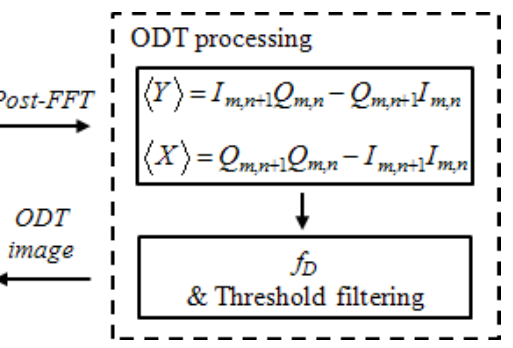
Figure 3. Flowchart of Doppler frequency shift calculation by a GPU.